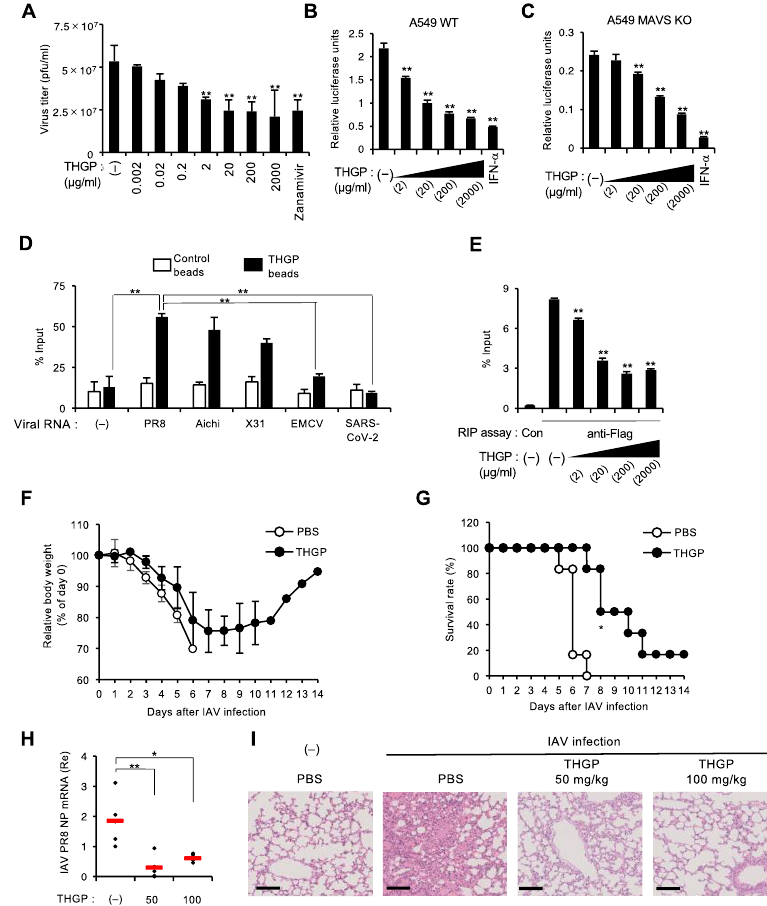
Figure 4. THGP directly abolishes IAV replication in vitro and in vivo. ( A ) Viral titers measured in MDCK cells after 24 h of infection with IAV in RAW264.7 cells in the presence of the indicated concentrations of THGP or 0.3 mM zanamivir as control. pfu, plaque-forming units. n = 3 samples per group. ( B – C ) Luciferase activity-based mini-genome assay of IAV replication in the presence of the indicated concentrations of THGP or 1000 U of IFN- α for 24 h in A549 WT ( B ) and A549 MAVS KO cells ( C ) after 24 h of transfection with IAV-related plasmids, including pPolI/ NP(0)luc2(0), Flag-PB2, PB1, PA, and NP. The CC 50 of THGP on A549 cells is evaluated (Figure S5B). ( D ) THGP pull down assay of viral RNAs including IAV PR8 (A/Puerto Rico/8/1934 H1N1), IAV Aichi (A/Aichi/2/68 H3N2), IAV X31 (H3N2), EMCV, and SARS-CoV-2, which were isolated from purified viruses. The % input of precipitated viral RNA with THGP beads is shown. ( E ) RIP assay with A549 MAVS KO cell lysates prepared after 48 h of transfection with the IAV-related plasmids including pPolI/ NP(0)luc2(0), Flag-PB2, PB1, PA, NP by using anti-Flag or control immunoglobulin G (con). The immunoprecipitated IAV RNA-like RNA of the reporter gene was measured by qRT-PCR with specific primers for firefly luciferase. ( F – G ) At 3 h after intranasal administration with THGP or PBS at a dose of 50 mg/kg of body weight, C57BL/6J mice were infected intranasally with 10 5 pfu/animal of IAV PR8. Body weight change ( F ) and survival rate ( G ) were monitored (n = 6 per group). Mice were intranasally administrated with THGP or PBS at a dose of 50 mg/kg of body weight every 2 days for 14 days. Day 0 indicates the time of initiation of administration. * p < 0.05 vs. control (a log rank-test). We also tested the effect of THGP on the body weight and survival of uninfected WT mice (Figure S6). ( H ) qRT-PCR analysis of IAV NP RNA levels in the lung tissues of MAVS KO mice at 48 h post-infection of IAV following administration with PBS ( − ), THGP (50 mg/kg), or THGP (100 mg/kg). ( I ) H&E stain of lung tissues at 72-h post-infection in MAVS KO mice following i.n. administration with PBS ( − ), THGP (50 mg/kg), or THGP (100 mg/kg). Bar: 100 μ m. ** p < 0.01 vs. control. * p < 0.05 vs. control. Data are presented as mean and s.d. (n = 3 in (A-E); n = 5 in (H)) and are representative of at least three independent experiments.